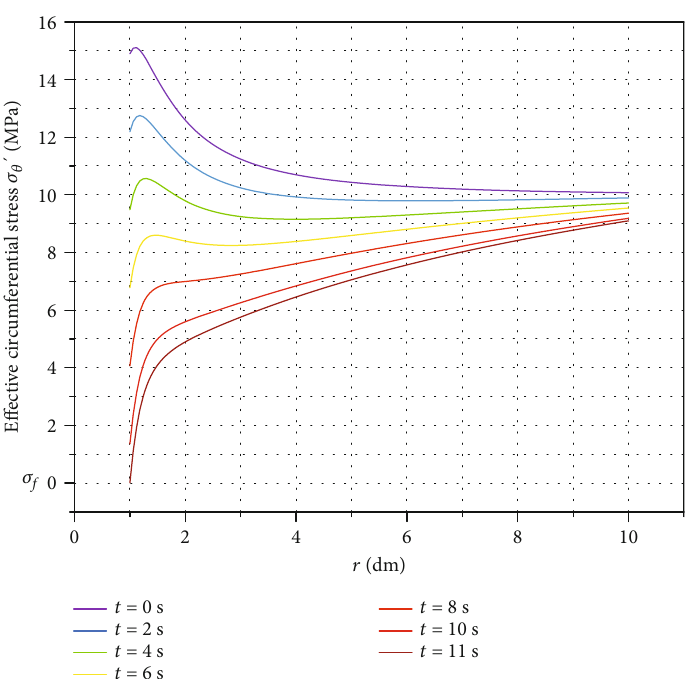
′ with radial distance for the case of wellbore fl uid fl owing into rock but no seepage Figure 7: The variation of σ θ